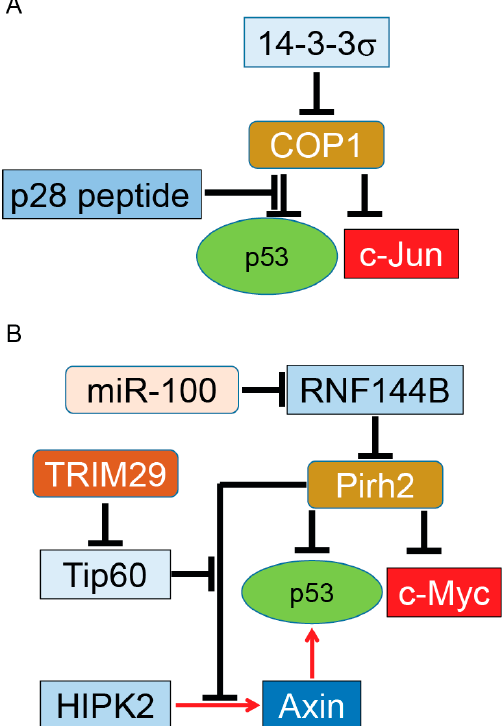
Figure 2. COP1 and Pirh2, tumor promoter and tumor suppressor. COP1 ( A ); and Pirh2 ( B ) serve as E3 ubiquitin ligases of p53. Overexpressed COP1 or Pirh2 can function as oncoproteins for the p53 tumor suppressor protein. On the other hand, COP1 and Pirh2 target and ubiquitinate c-Jun and c-Myc oncogenes, respectively. This dual function indicates COP1 and Pirh2 have a putative role in tumor development in tissue- and grade-dependent manners. Similar to Mdm2, COP1 and Pirh2 are regulated with their partners. It needs to be determined whether these regulators can switch the function of these two proteins from tumor suppressor to oncoprotein during tumor growth. Induction of gene expression or protein activation is shown by red arrows and inhibition of gene expression or block protein activity is shown by T-bars. Tip60, Tat-interactive protein of 60 kDa.